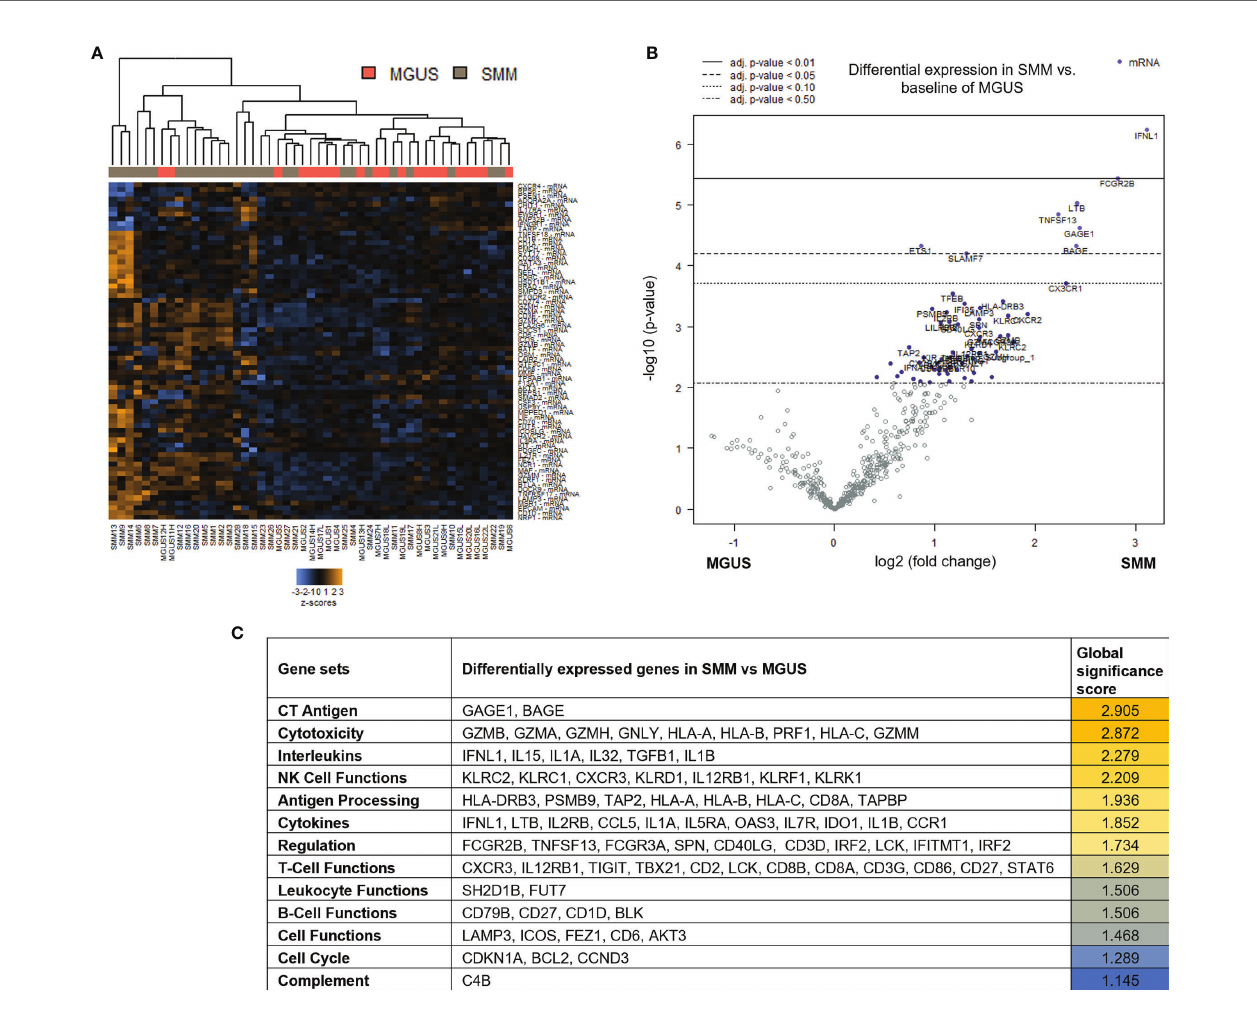
FIGURE 1 | Genes associated with cytotoxicity were signi fi cantly upregulated in patients with SMM compared to MGUS. (A) Heatmap showing the unsupervised hierarchical clustering of patients with MGUS (n=22) and with SMM (n=28) based on the NanoString PanCancer Immune panel. (B) Volcano plot showing differentially expressed genes in SMM compared to MGUS. (C) Ranking of gene set functions according to the Global Signi fi cance Score quanti fi ed by NanoString software nSolver